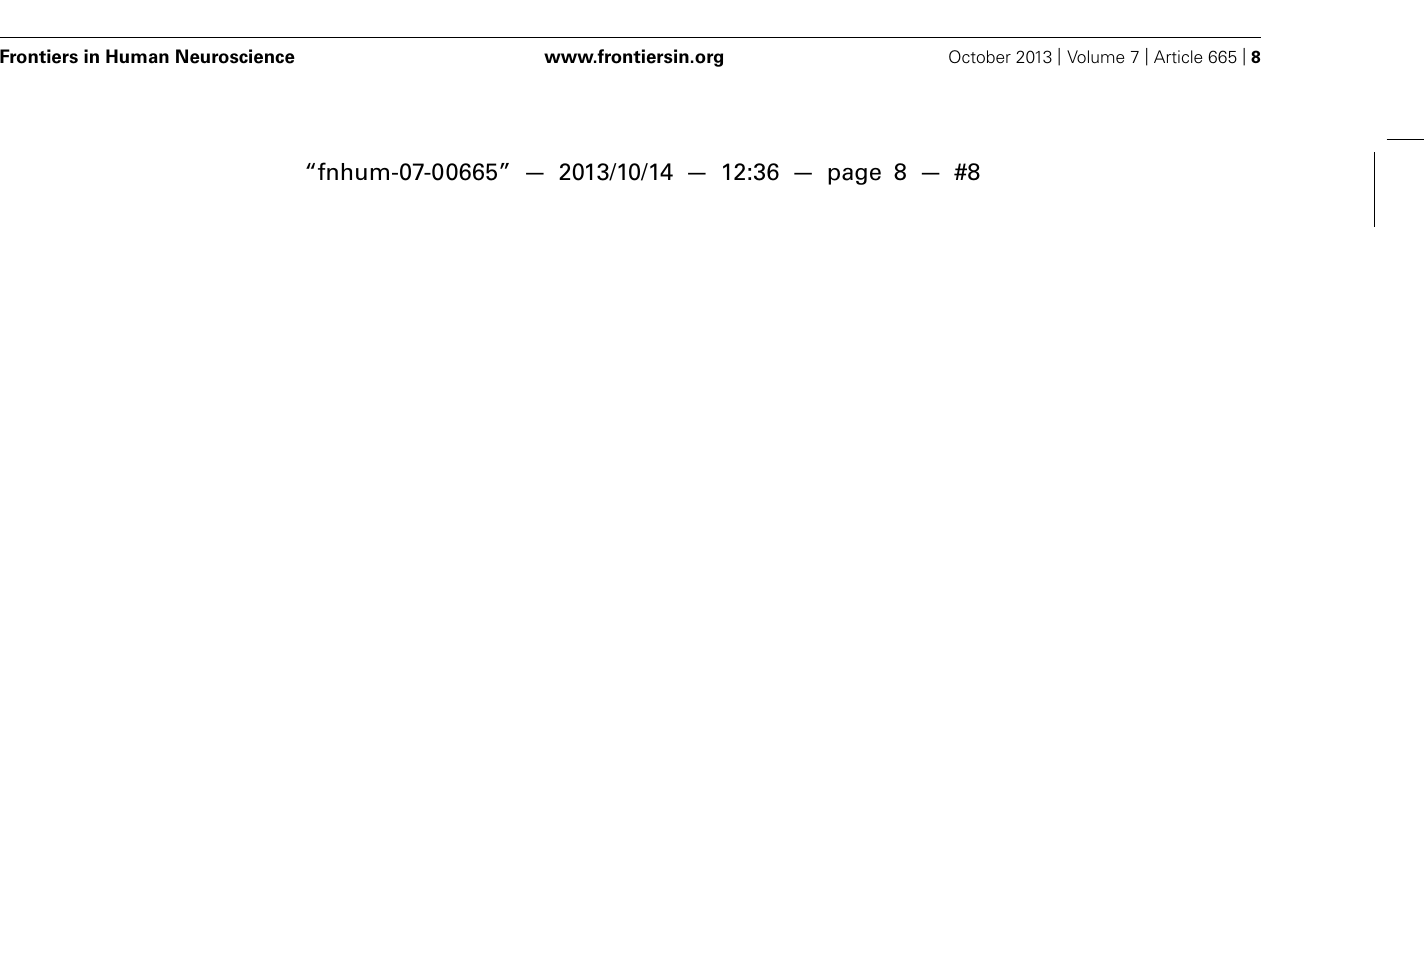
FIGURE 3 | Sequence length effects on average ISIs for the healthy speaker group (A), the hypokinetic speaker group (B), and the ataxic speaker group (C) . Linear mixed effects models revealed significant effects of sequence length on average ISIs in the healthy speakers and hypokinetic speakers with Parkinson’s disease. The line of best fit is